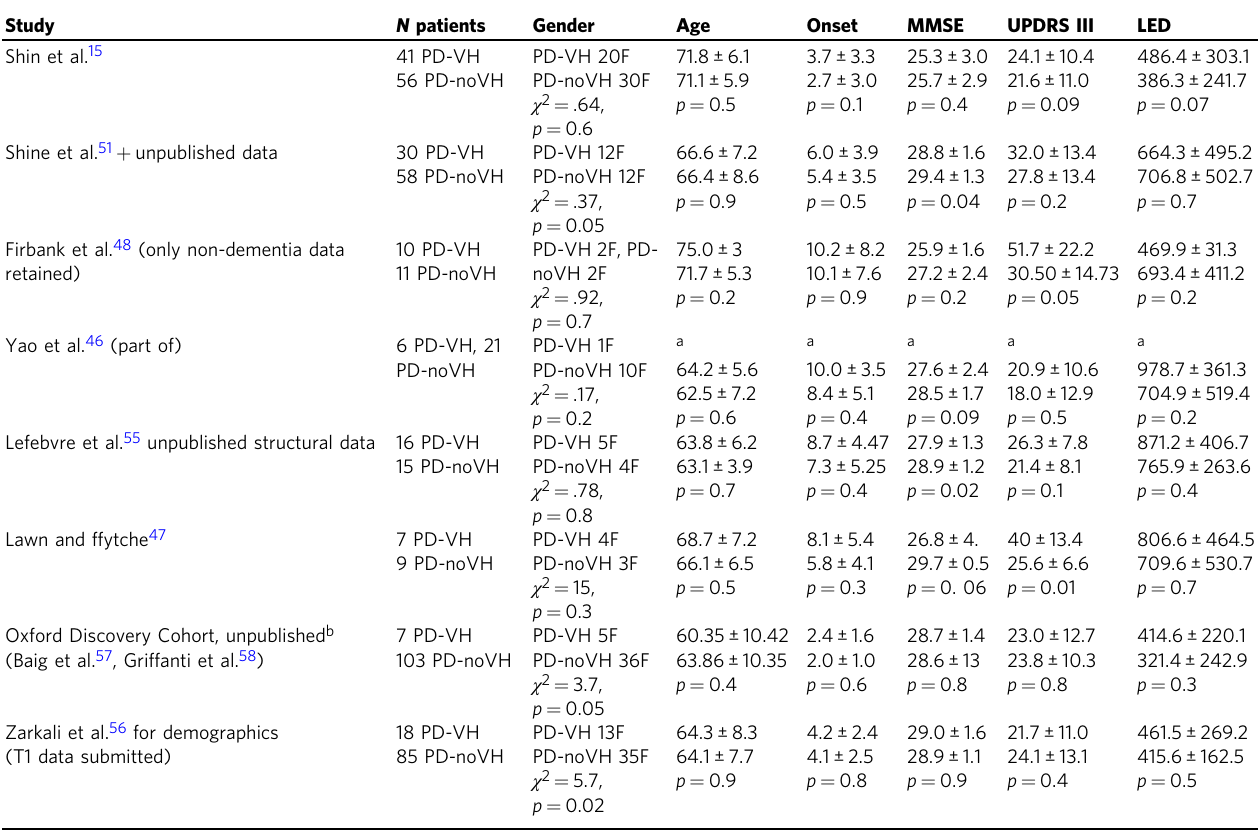
Table 1 Demographics and clinical information by